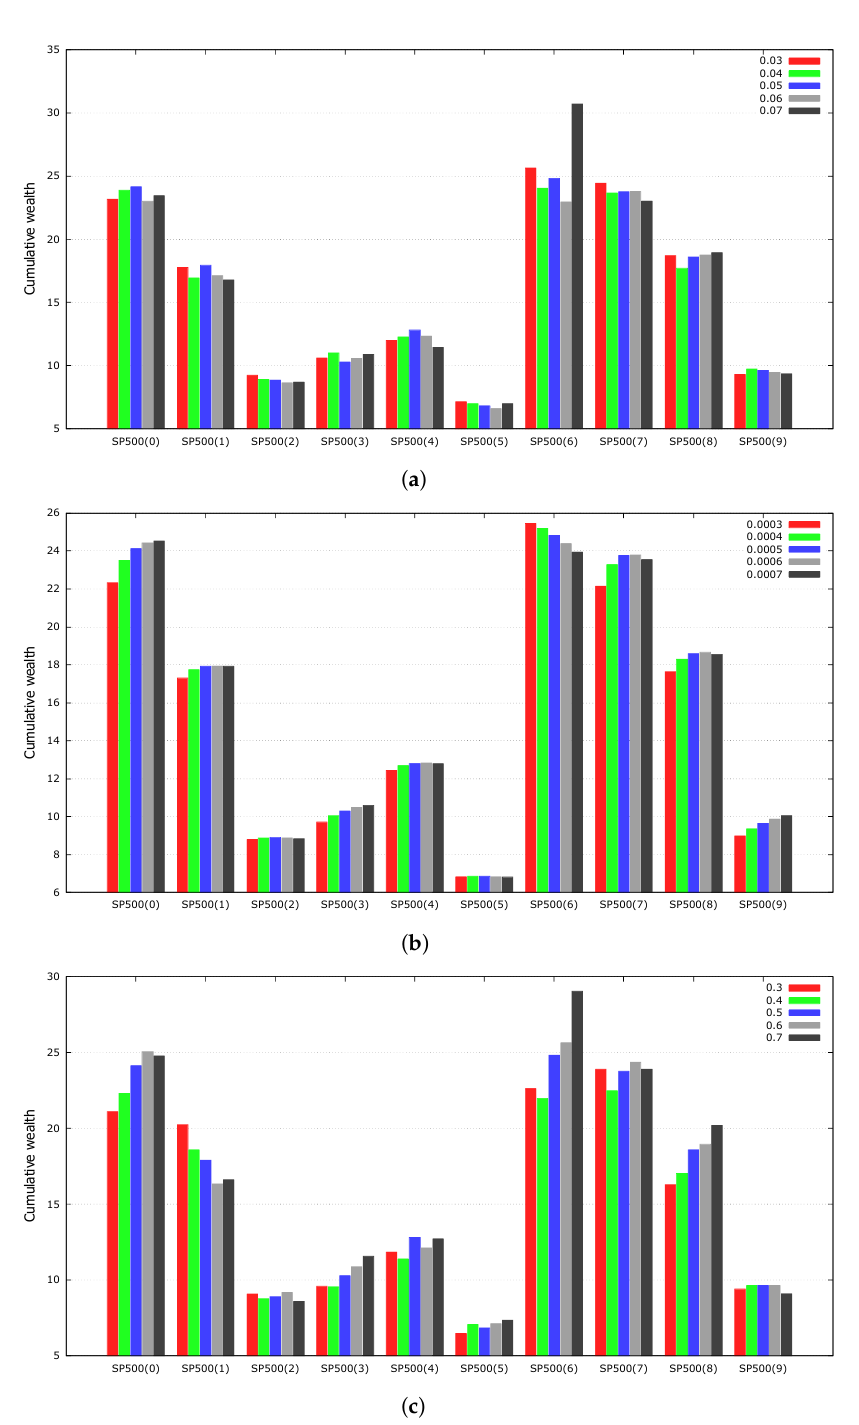
Figure 4. Cumulative wealth according to the values of the parameters. The values we used for the GMR were centered on all graphs. The transaction cost rate is 0.5%. ( a ) µ : Probability of a gene mutation; ( b ) α : Parameter used for portfolio vectors; ( c ) β : Parameter used in the local